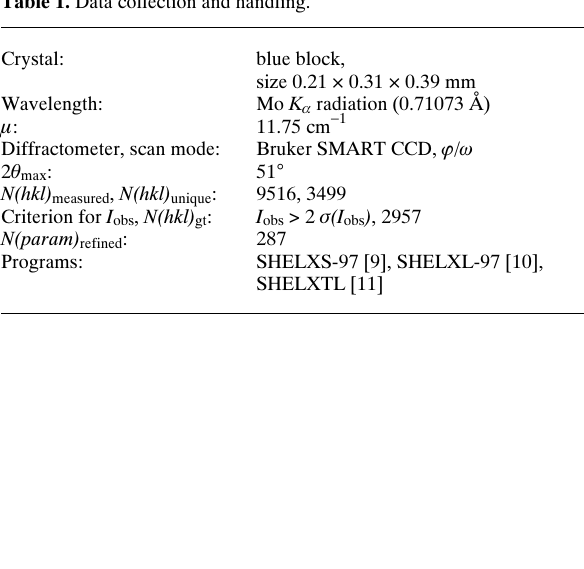
Table 2. Atomic coordinates and displacement parameters (in Å 2 ) . Table 1. Data collection and